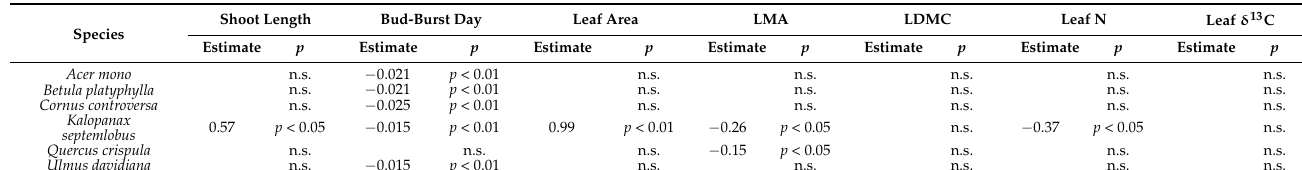
Table 2. The results of GLMM analysis (for K. septemlobus , GLM analysis) ( p -value and estimated slope) for the effect of snowmelt treatment. Estimate = estimated slope of the models; n.s. = non- significant. The estimates were shown only when the p -value ( p ) was less than 0.05.